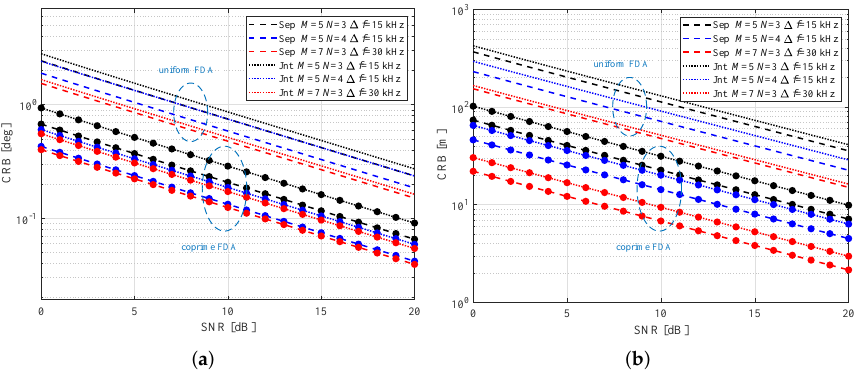
Figure 7. CRBs of joint/separate DOA-range estimations in stochastic signal case. ( a ) CRB of DOA estimation. ( b ) CRB of range